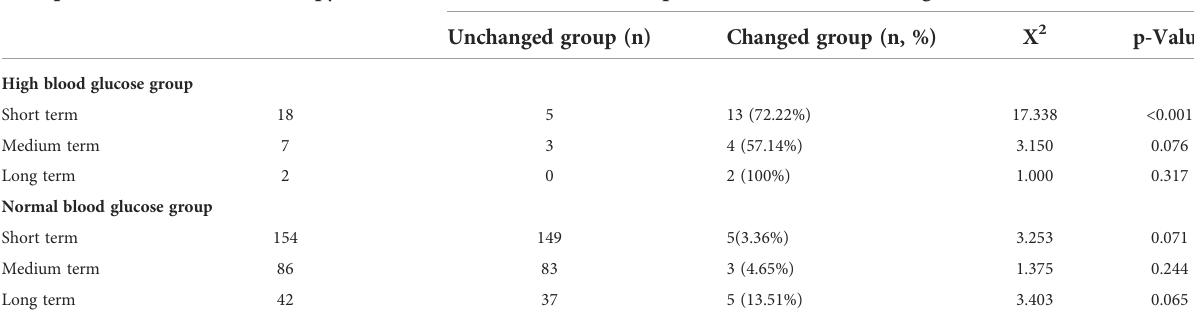
TABLE 4 Comprehensive clinical ef fi cacy of short, medium and long term treatment on blood glucose levels. Data periods Before therapy (n) Therapeutic effect base on blood glucose levels Unchanged group